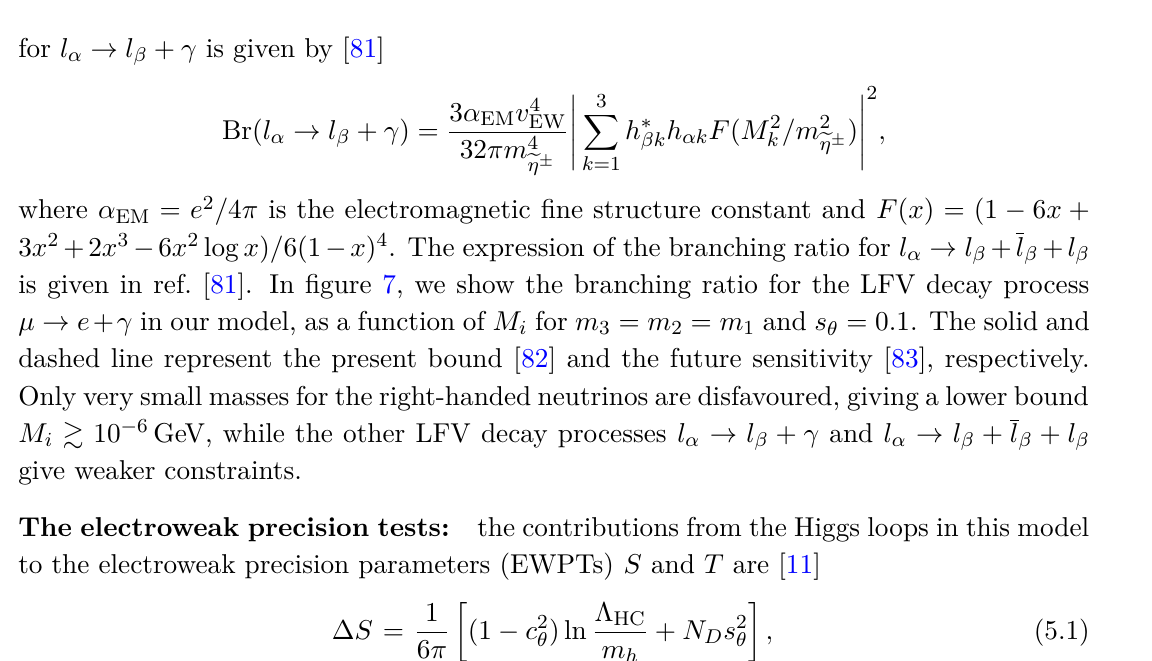
Figure 7 . Br ( µ → eγ ) as a function of M i for m 3 = m 2 = m 1 and s θ = 0 . 1 . The solid and dashed line represent the present bound [82] and the future sensitivity [83], respectively. The various colors of the points represent the same values of M i as in figures 4 and